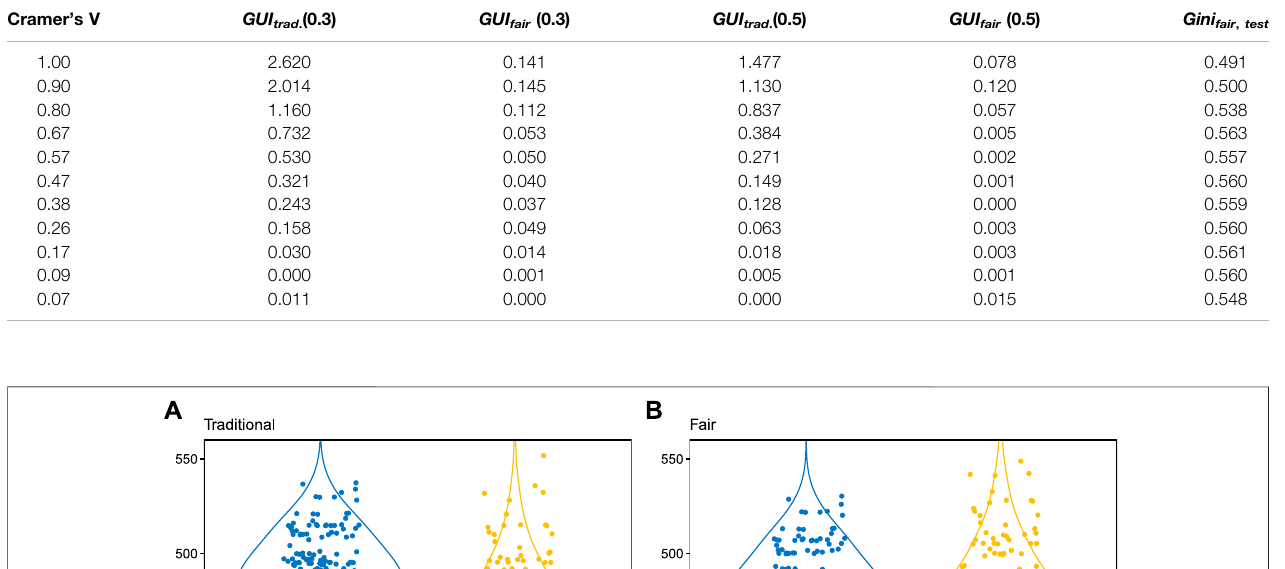
TABLE 8 | Comparison of the variable Status for the traditional model (left) and female (center) and male (right) gender in the fair model. Bin Dist %Bad Woe Points Dist|f %Bad|f Woe|f Points|f Dist|m %Bad|m Woe|m Points|m No checking account 0.281 0 < (cid:1) ... < 200